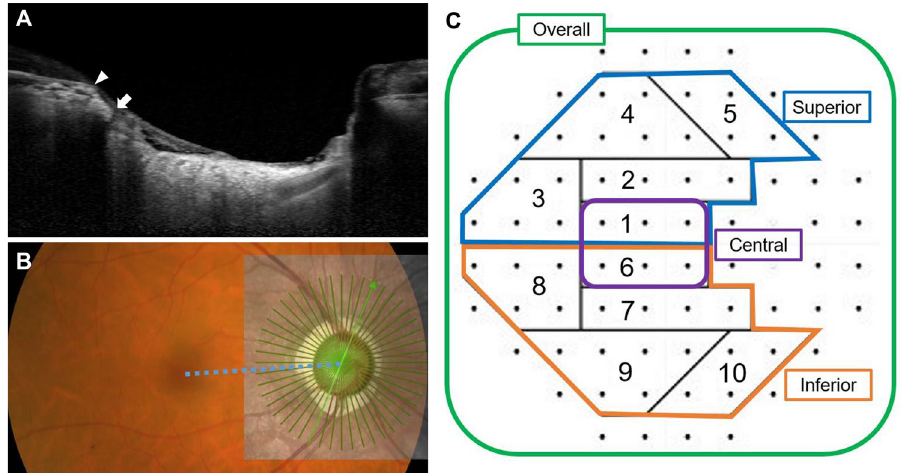
Figure 3. Methods for measuring the length and angular location of the longest externally oblique border tissue (EOBT) and classification of visual field test points. ( A ) Cross-sectional image of the optic nerve head. EOBT length was measured as the distance between Bruch’s membrane opening (BMO) (arrowhead) and the inner end of the border tissue (arrow). ( B ) Enhanced depth imaging optical coherence tomography (EDI-OCT) scan was obtained using 48 radial line B-scans (each at an angle of 3.75°). The OCT image was superimposed on the fundus photo of the same eye. The angular location of the maximum EOBT was defined as the angle between the fovea-BMO axis (dotted blue line) and the reference line (light green line with an arrowhead) obtained while measuring the maximum EOBT length. ( C ) Ten visual field sectors based on anatomical relationships between visual field test points in the Humphrey 30–2 test and location of retinal nerve fiber layer bundles. Sectors 1 and 6 were regarded as the central zone. Five upper sectors—sectors 1 to 5—and five lower sectors—sectors 6 to 10—were regarded as the superior zone and inferior zone, respectively.